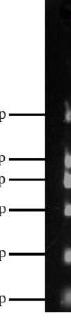
Figure 2. Detection of Pg001327.1 PCR products by electrophoresis. Note: M: DL2000 DNA Marker; 4CL2: Target gene.